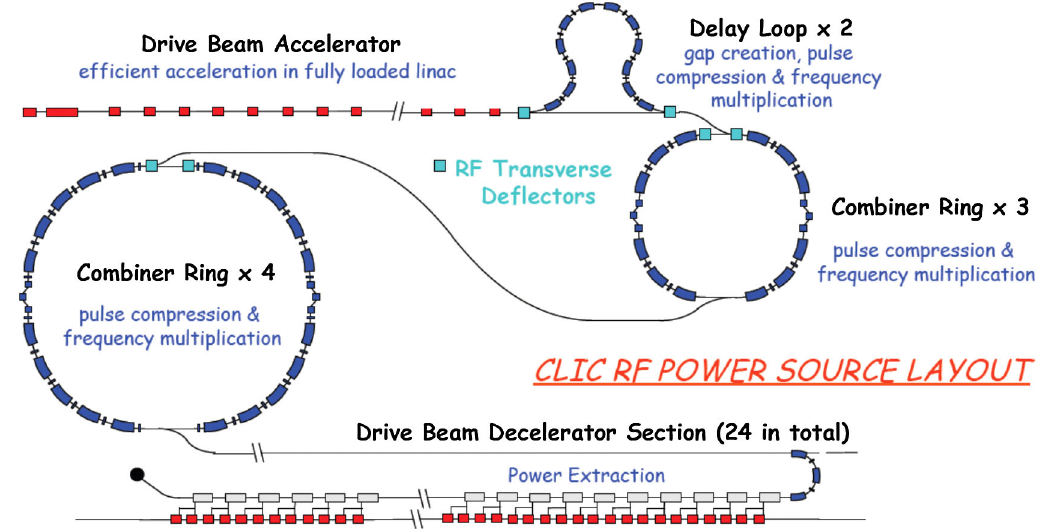
FIG. 8. Schematic layout of a CLIC rf power source complex as presented in [2].